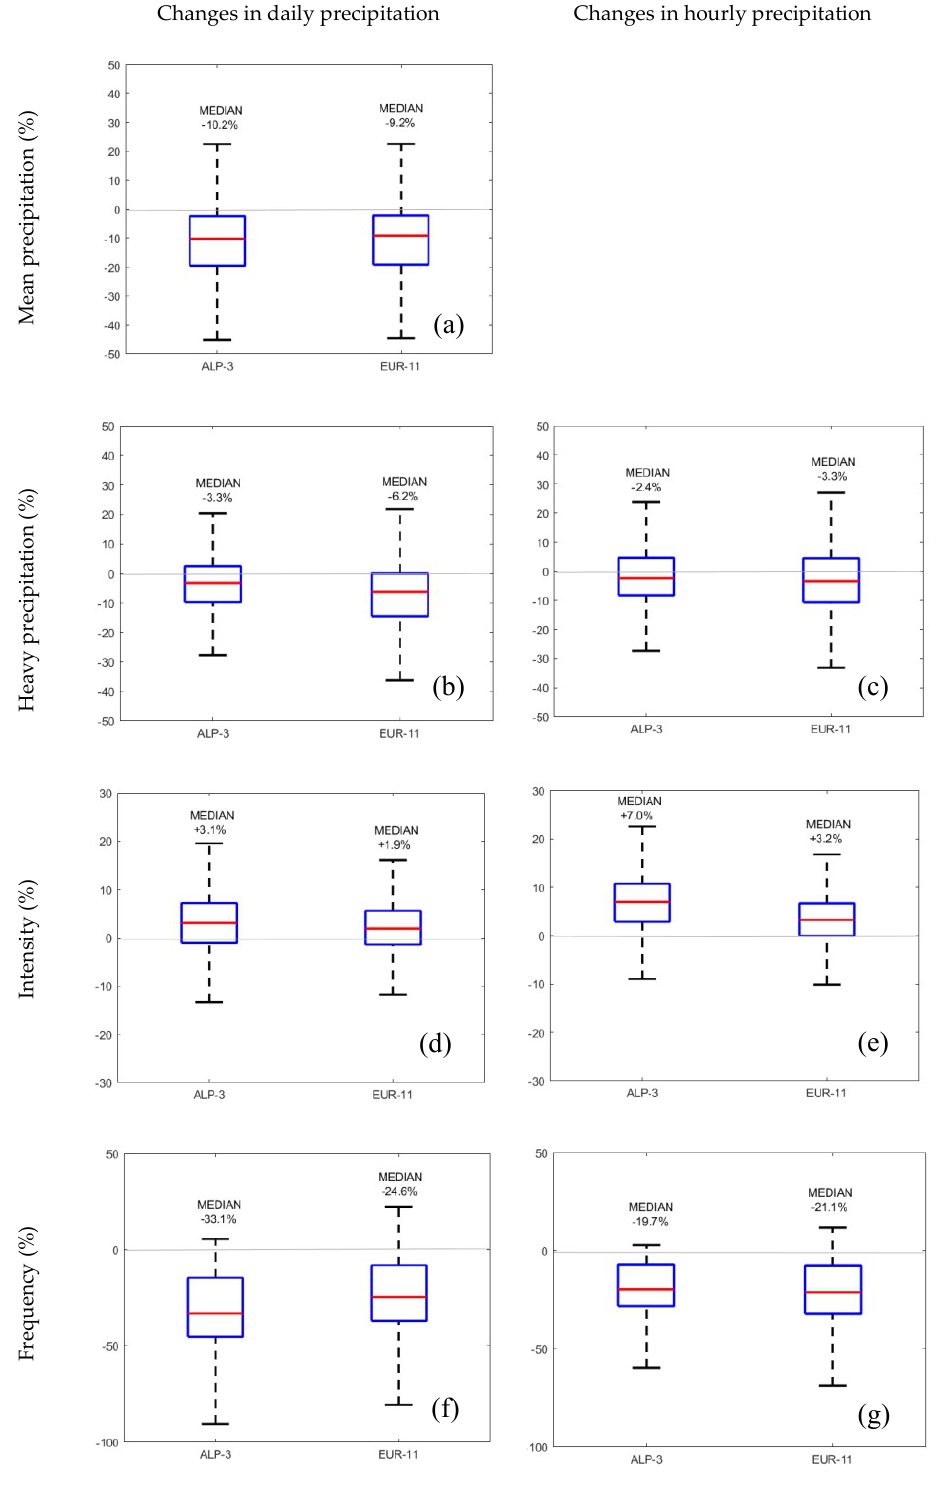
Figure 8. “Whiskers” box plots of daily ( a , b , d , f ) and hourly ( c , e , g ) projected changes of precipitation resulting from ALP-3 and EUR-11